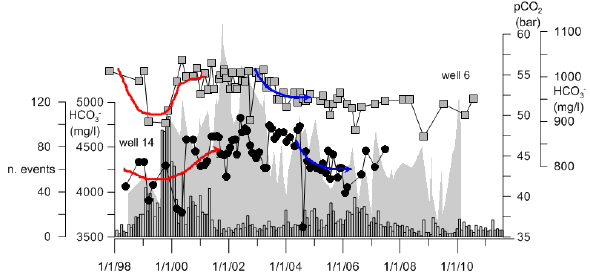
Figure 7. From top to bottom: time trends of the SO 42− /HCO 3− Figure 6. Time trends of HCO 3− contents at wells 6 and 14. Arrows indicate phases of increases (red) and decreases (blue) in HCO 3− con- ratio, NO 3− content, and HCO 3− content at well 19. The time trend values, computed for the hy- tents. The time trend of pCO values, computed for the hydrothermal aquifer by Caliro of pCO 2 2 drothermal aquifer by Caliro et al. [2011], is plotted as a shaded area. et al. [2011], is plotted as a shaded area. The histogram shows the The histogram shows the monthly number of seismic events. monthly number of seismic